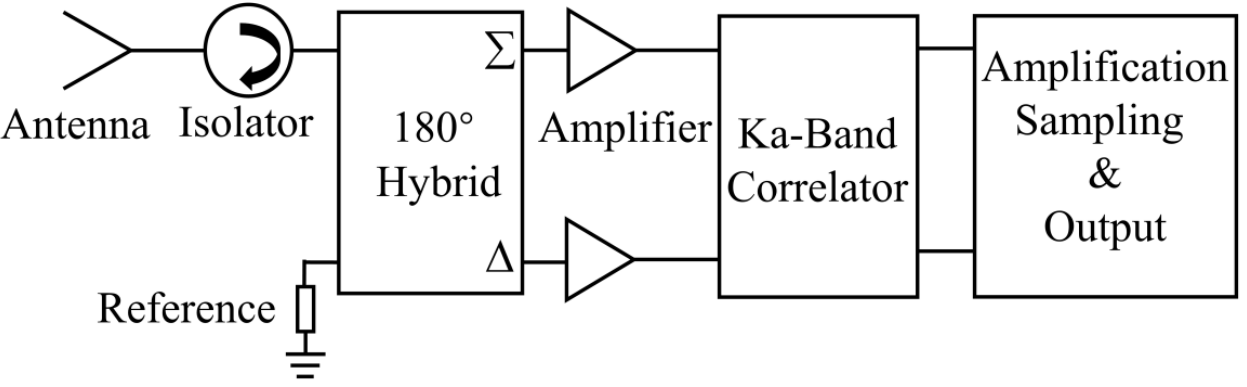
Figure 17. The block diagram of the millimeter-wave radiation temperature measurement system. The external noise signal is received by the horn antenna and converted to the mi- crostrip line through the waveguide microstrip conversion structure. Then, the noise signal passes through the 180 ◦ hybrid bridge and is added or subtracted from the noise signal generated by the reference resistance to obtain two signals combined by external noise and internal resistance noise. If the equivalent noise temperature of the noise signal received by the antenna and the noise signal generated by the reference resistance is expressed